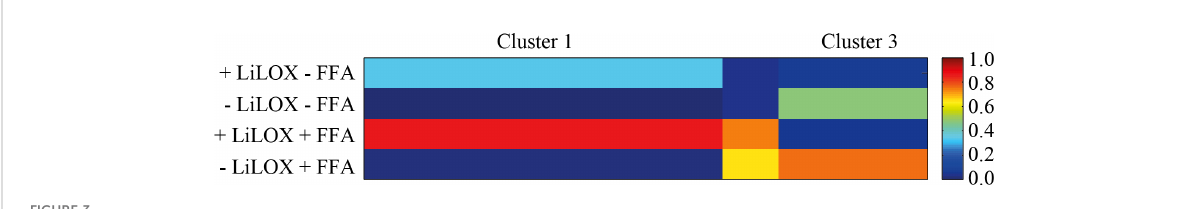
FIGURE 3 Ex vivo assay of LiLOX. After extraction of the total metabolites from L. incisa , the mixture was solubilized in bis-tris propane buffer pH 7.5, and split in four samples named A, B, C and D. Puri fi ed LiLOX was added to the samples A and C. Pure free PUFAs (FFA) were added to samples C and D as internal standards. All samples were analyzed following a non-targeted method, by LC-MS, and the data were analyzed by automatic clustering using the software MarVis. The fi gure represents the One-dimensional Self-Organizing Map (1D-SOM) revealing putative substrates and putative products with and without LiLOX reaction. The heat map colors represent average intensity values according to the color map on the right-hand side. The width of each cluster is proportional to the number of features assigned to this